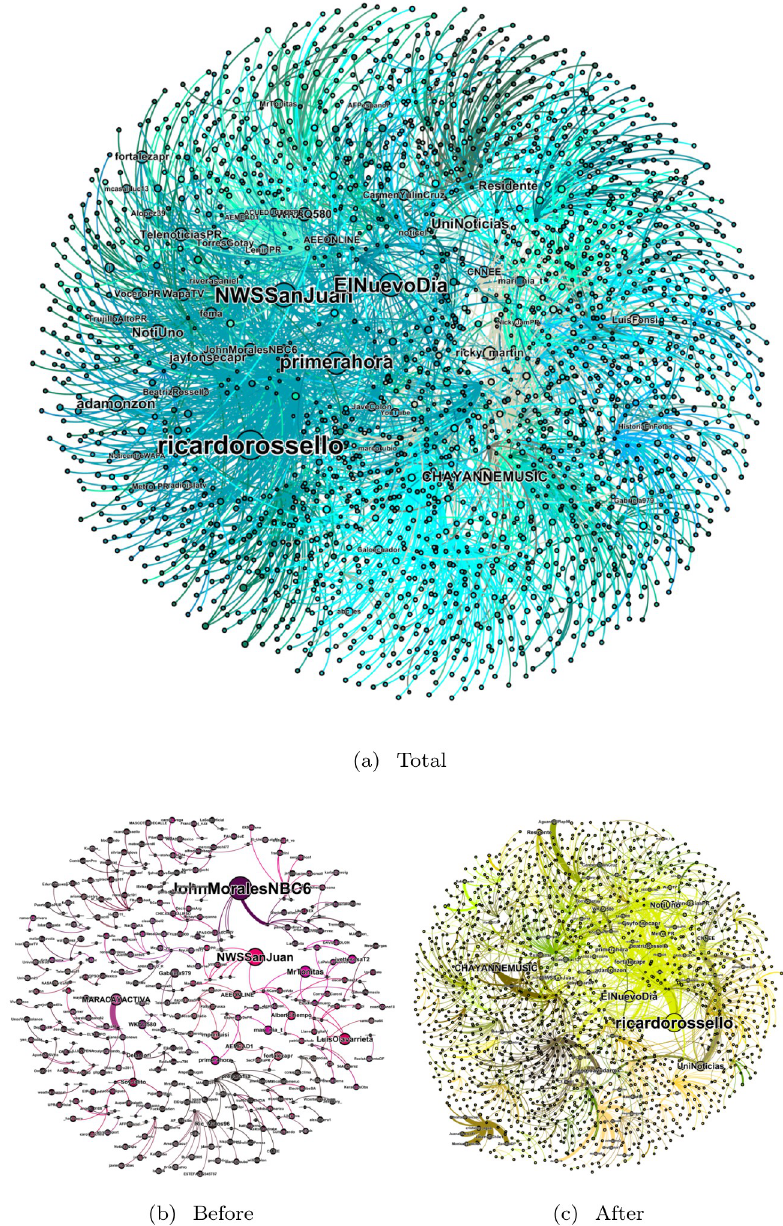
Fig 8. The networks of tweets using one or more of the keywords in Table 1 from users likely to be affected by Hurricane Maria or to have a direct connection to someone affected: (a) September 16 to October 15; (b) Before hurricane landfall on September 20; and (c) After the hurricane leaves the